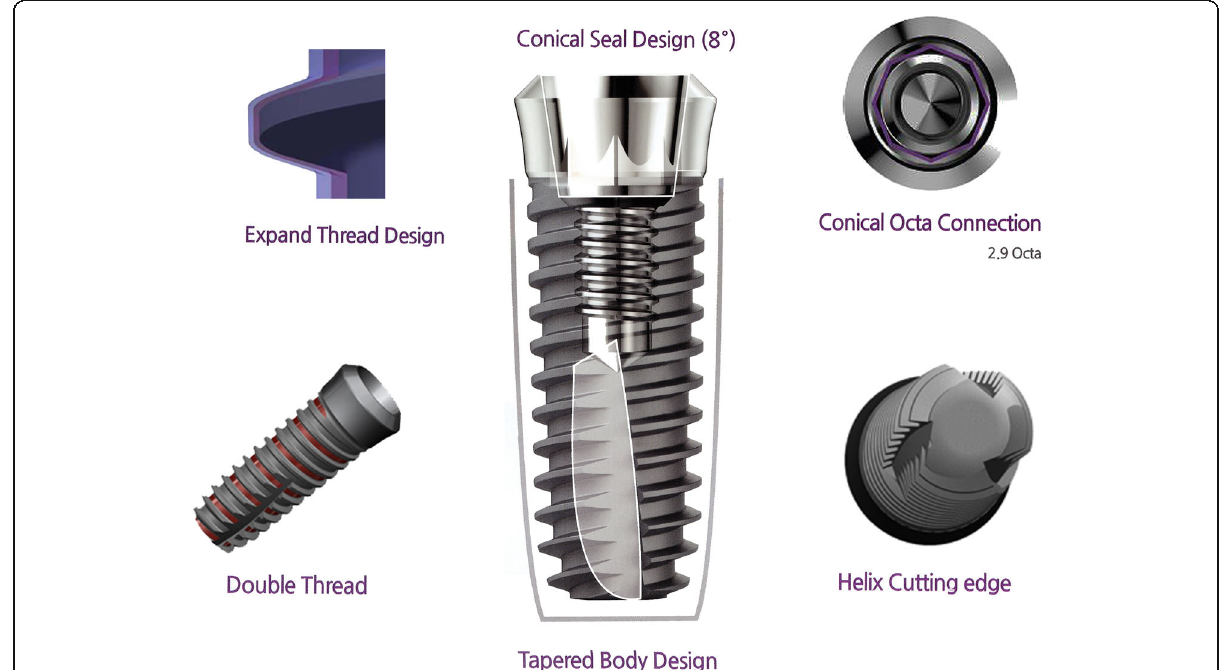
Fig. 1 Macroscopic design of the Stella® implant system used in this study. The 8° conical seal design located in the prosthetic connection part prevents screw loosening. The three spiral cutting edges enable self-tapping, facilitate rapid implantation, and minimize the resistance of the